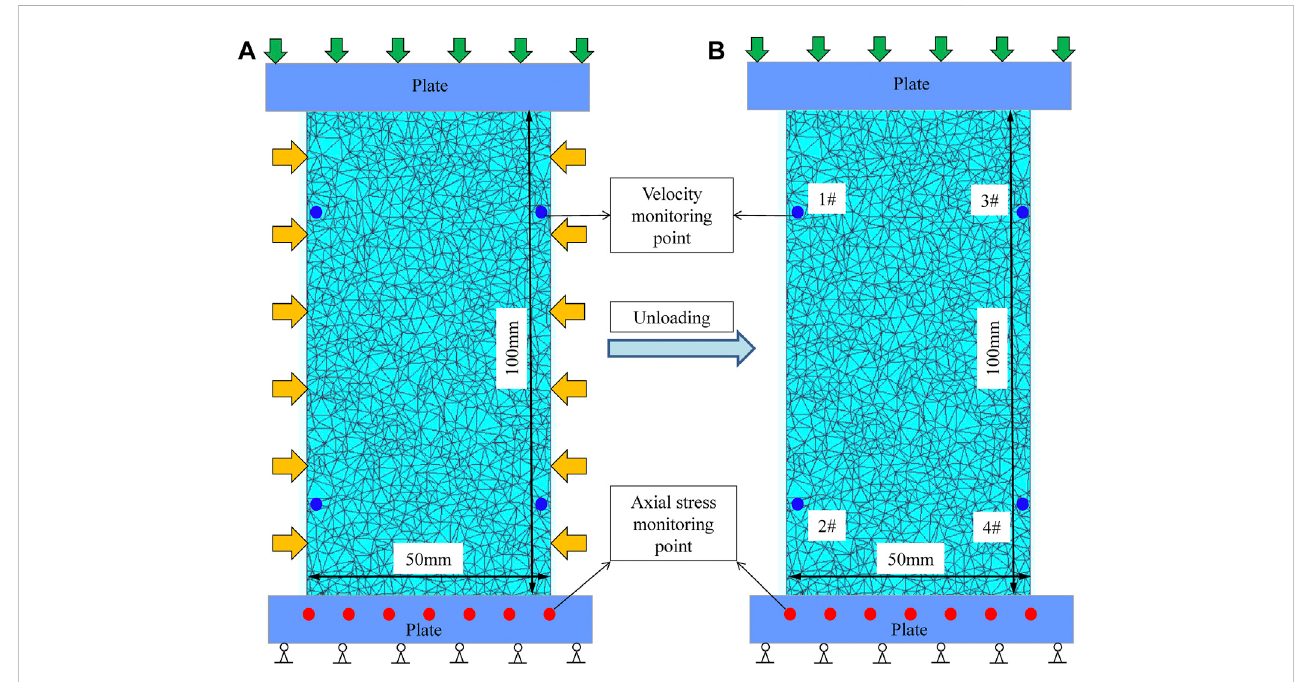
FIGURE 1 UDEC-Trigon model of coal sample incl. Location of monitoring points: (A) before unloading, (B) after